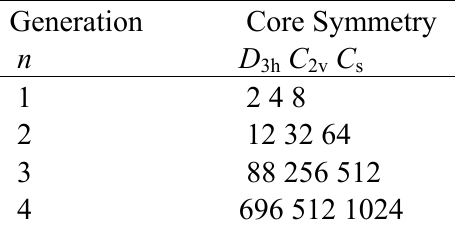
Table 1. Number of rotamers in [3]star compounds with different symmetry and arms, which contain repeat units with trans configured olefinic double